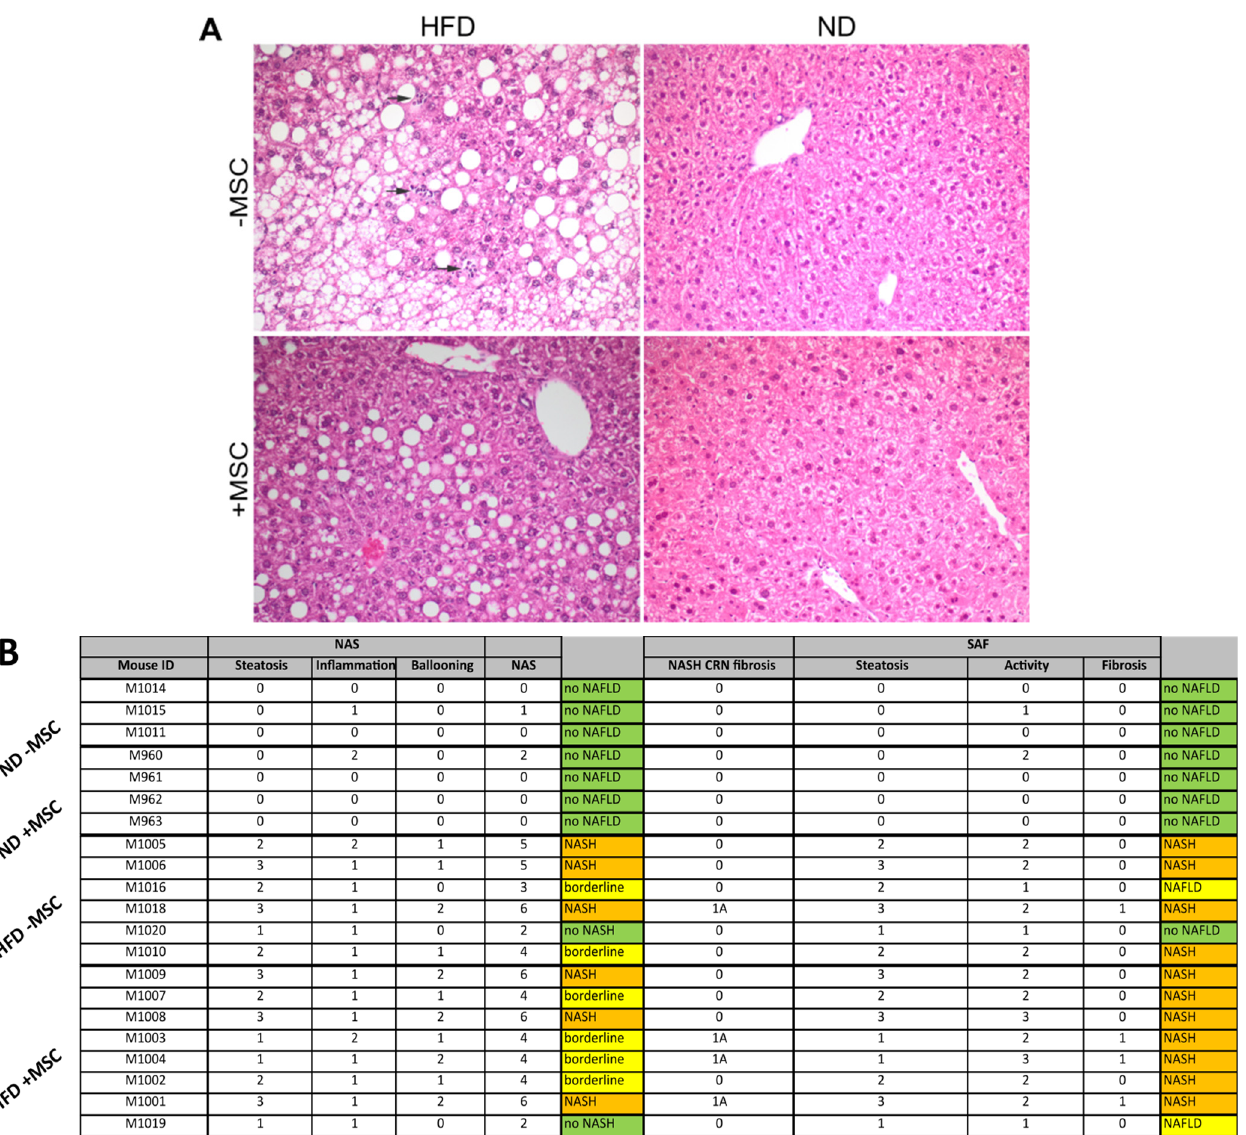
Figure 1. High-fat-diet-fed mice develop NASH: ( A ) HE stain of liver slices from animals fed either the control (ND) or the high fat diet (HFD); where indicated, animals received MSC (+MSC) or were left untreated ( − MSC). Arrows indicate inflammatory foci. Pictures are representative for 2 different animals out of each group. ( B ) Determination of NASH scores using either the NAS [34] or the SAF [35] score; 3 (ND − MSC), 4 (ND + MSC), 6 (HFD − MSC) and 8 (HFD + MSC) animals per group are included for analysis. Numbers in columns represent the score according to the respective scoring system used (cf. Materials and Methods). The pathological evaluation of the scores revealed either no NAFLD (green), NASH (orange), or borderline and NAFLD (yellow).